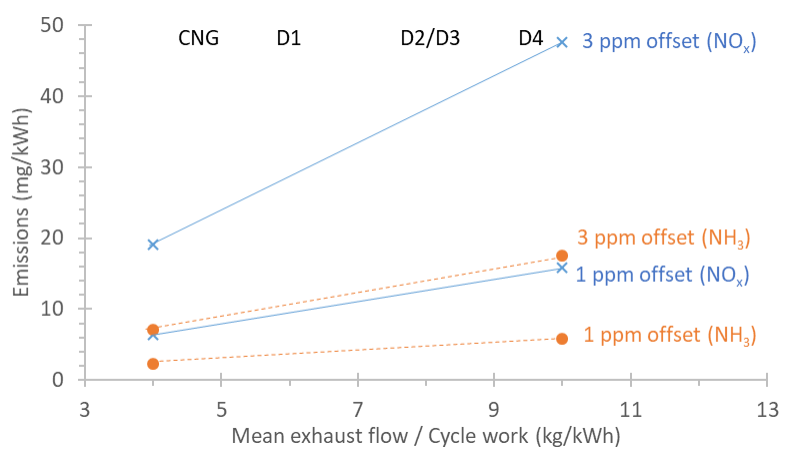
Figure 10. Zero levels and minimum detection limits. CNG = compressed natural gas engine; D = diesel